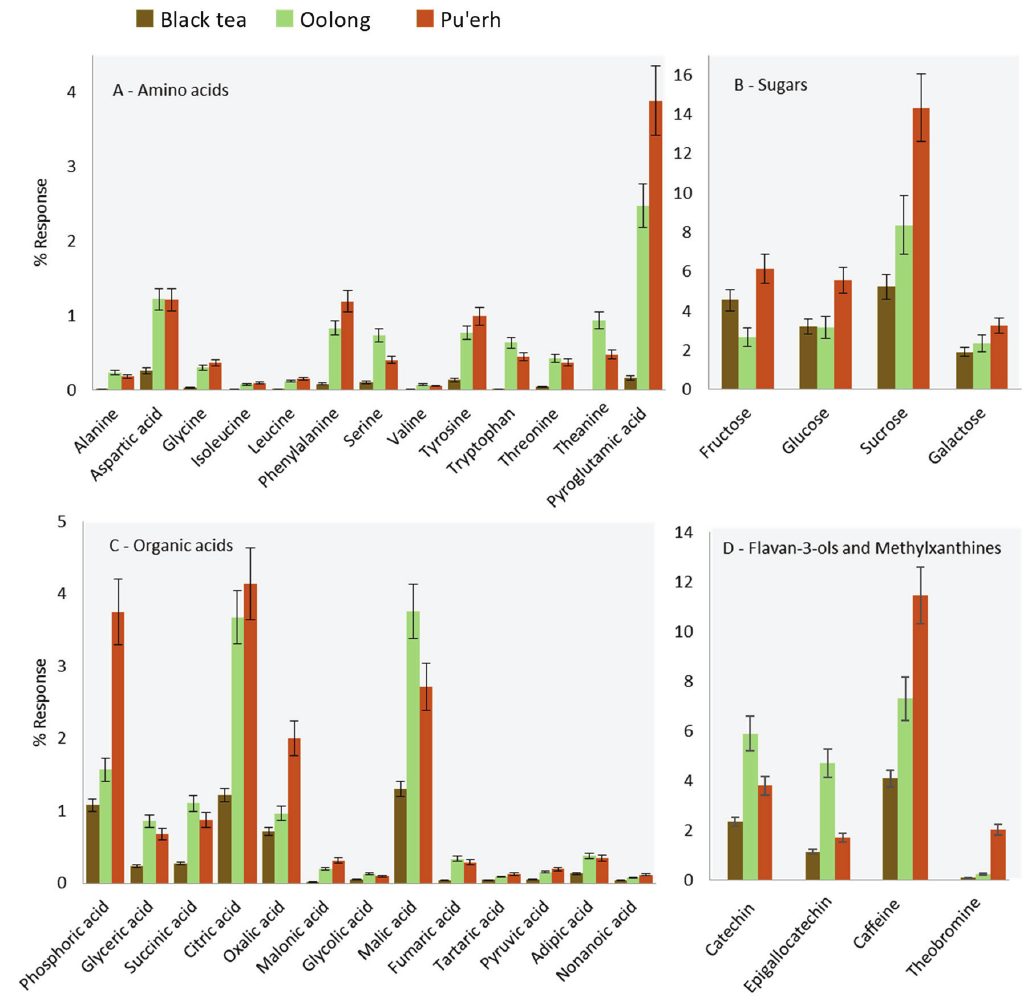
Figure 3. Histograms illustrating the relative distribution (% response) for targeted features based on chemical classes ( A : amino acids, B : sugars, C : organic acids, D : catechins, and methylxanthines). Error bars correspond to ± SD over all samples belonging to the same class.